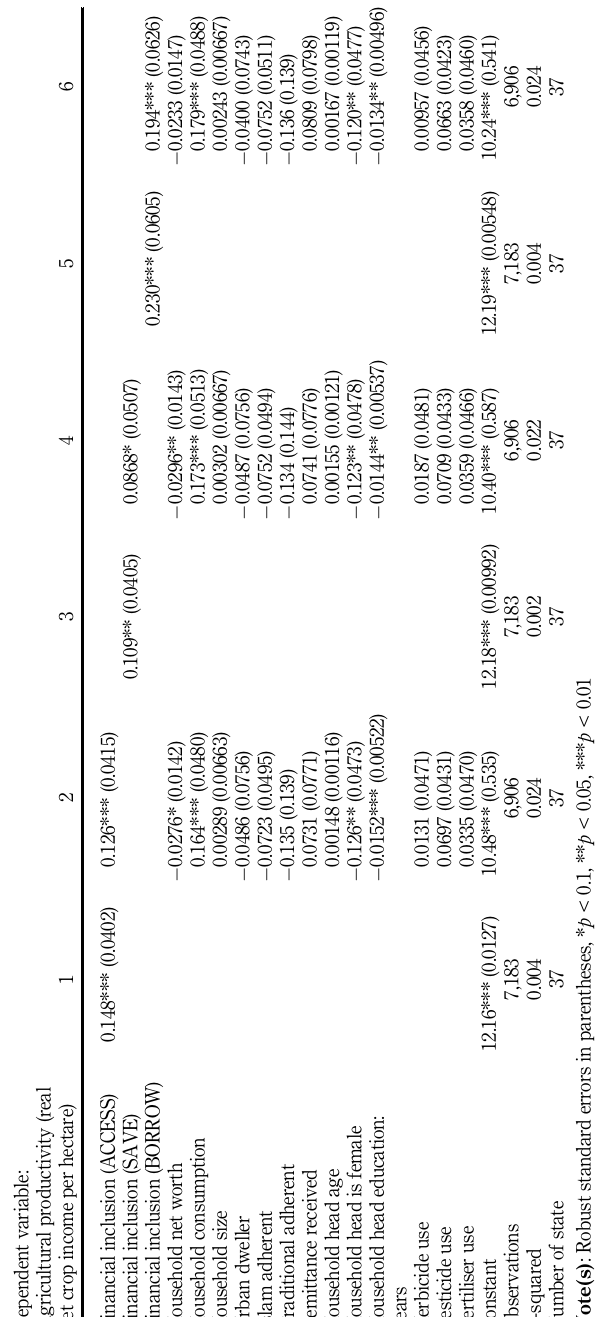
Table 5. Effects of